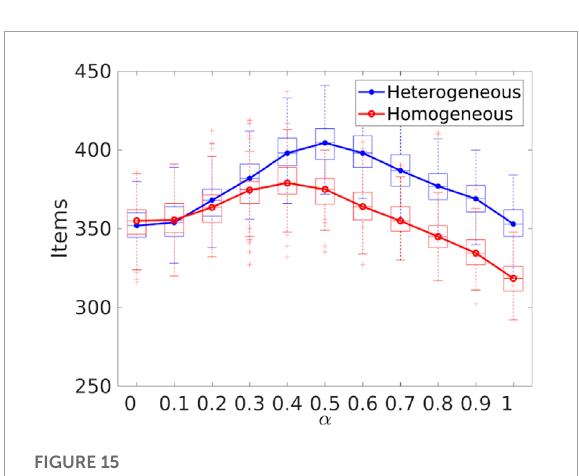
FIGURE 15 Item collection with homogeneous and heterogeneous errors with different values for α . The peak for item collection is 0.4 for the homogeneous error model and 0.5 for the heterogeneous error